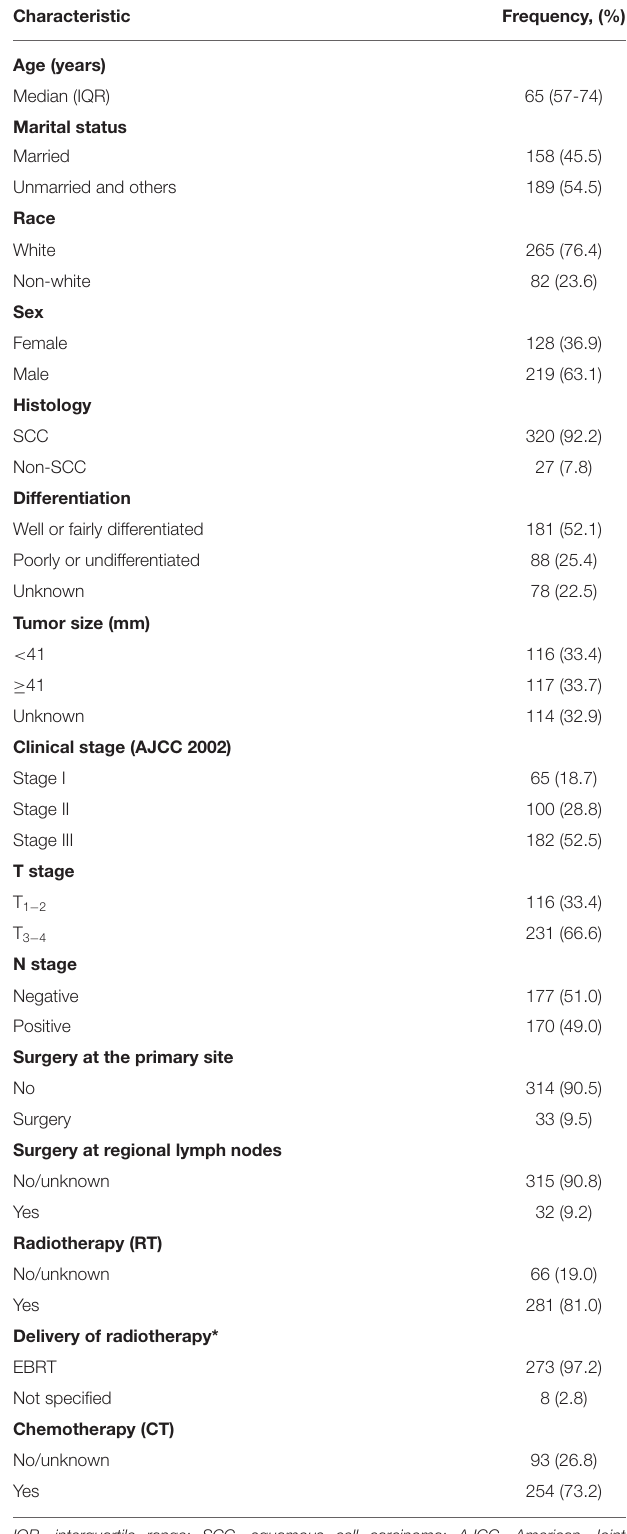
TABLE 1 | Baseline characteristics of the CEC